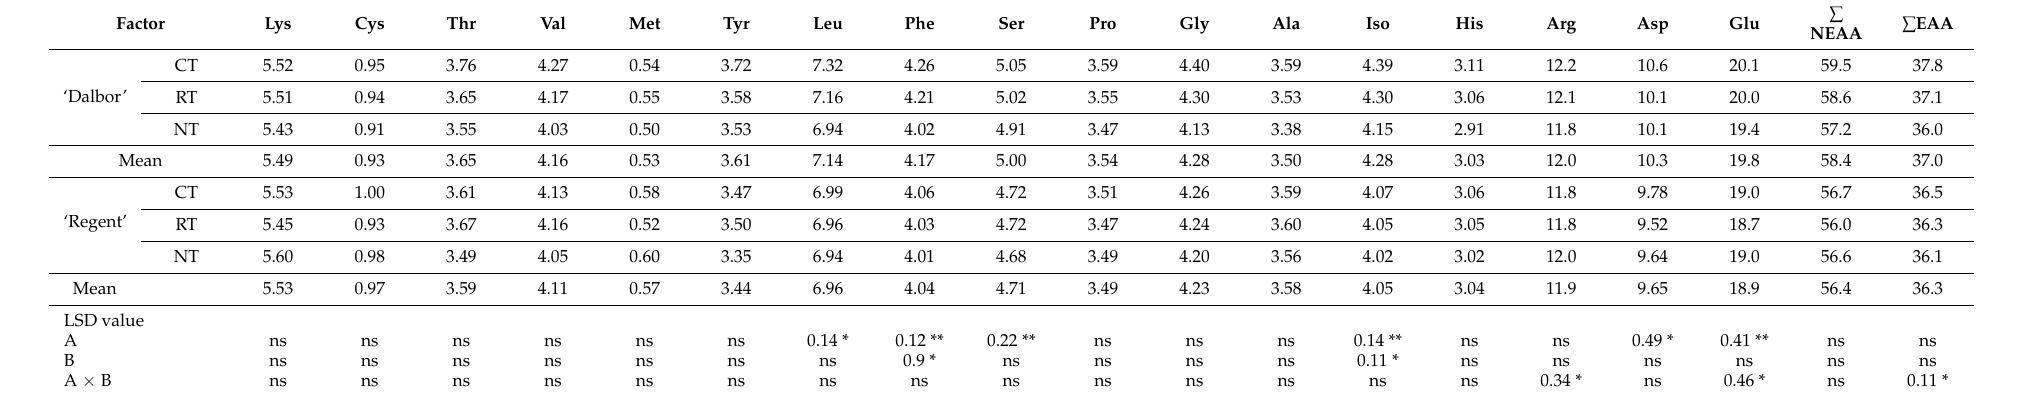
Table 6. Amino acid profile (g 16 g − 1 N) of yellow lupin (YL) depending on variety and tillage